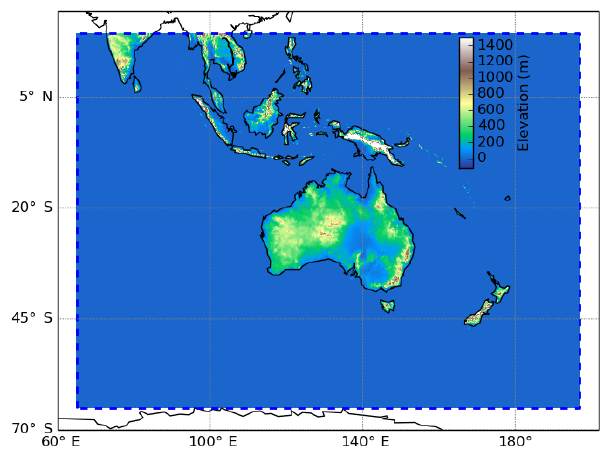
Figure 1. The BARRA-R domain is enclosed by the dashed box, with the model orography